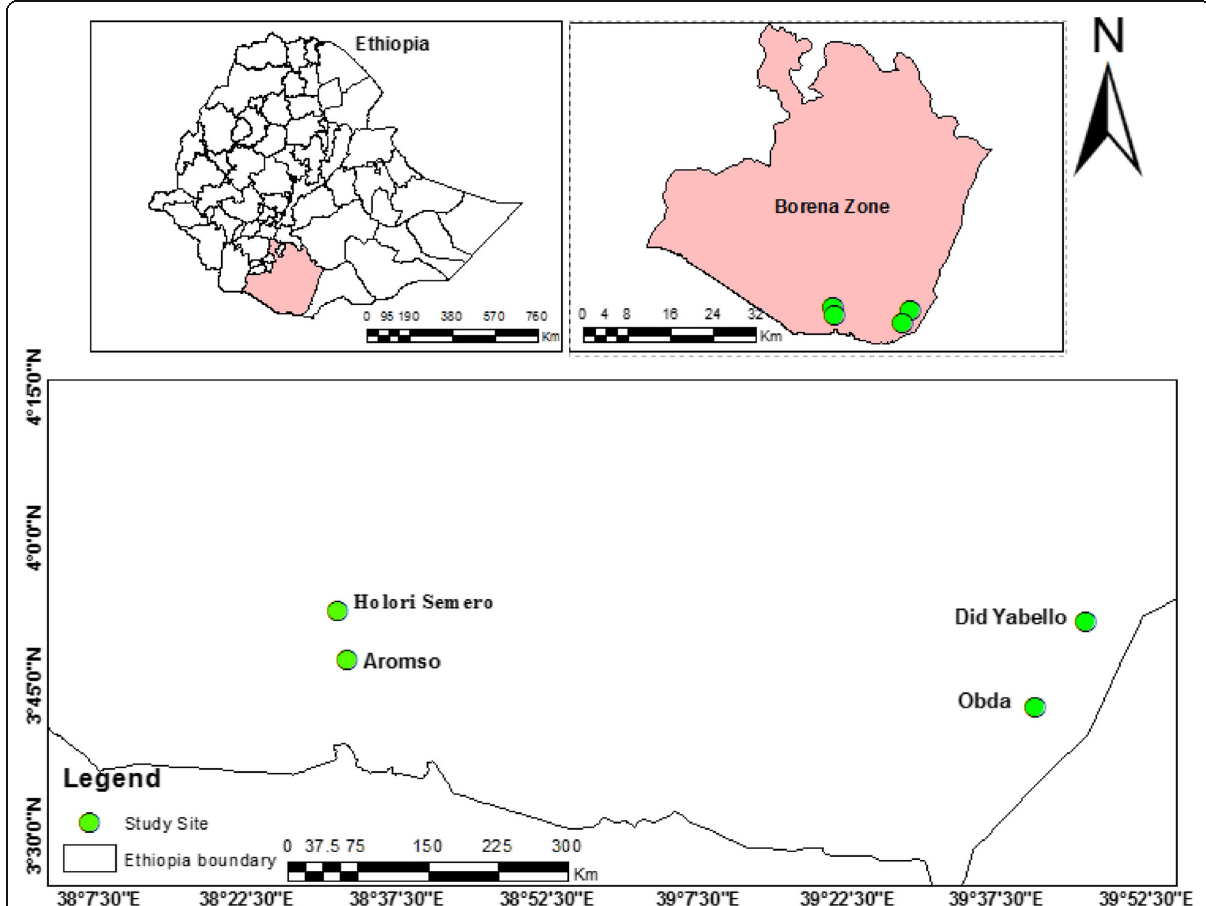
Fig. 1 Updated location map of the study area (Yabello and Dire